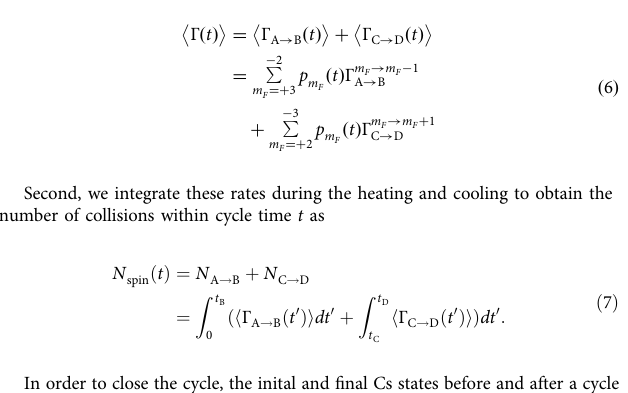
reservoir. Using the population distribution of the quasi-spin levels at the cycle